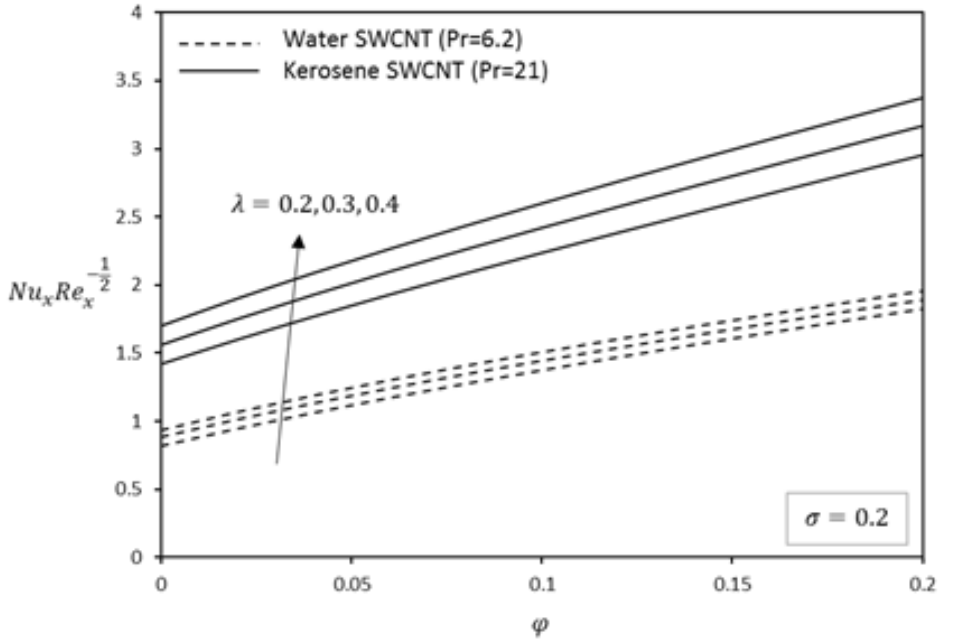
Figure 17. Effect of λ on Nusselt number for water-kerosene based fluid.